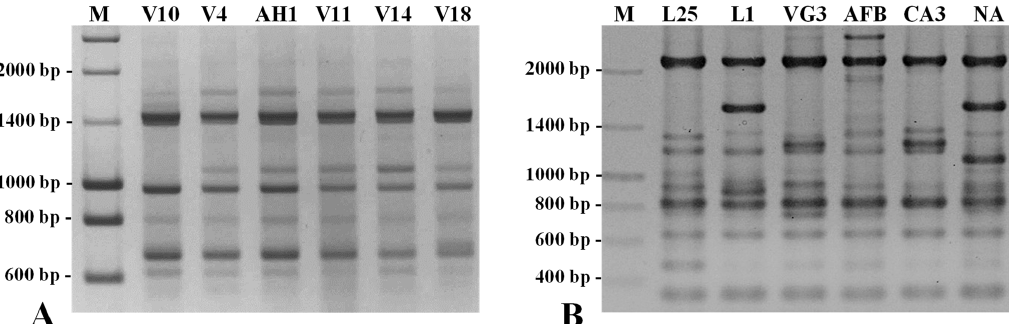
Figure 5. Randomly ampli fi ed markers analyzed by agarose gel electrophoresis. ( A ) RAPD pa tt erns of 6 germplasm accessions ampli fi ed by primer OPAN11. ( B ) ISSR pa tt erns of 6